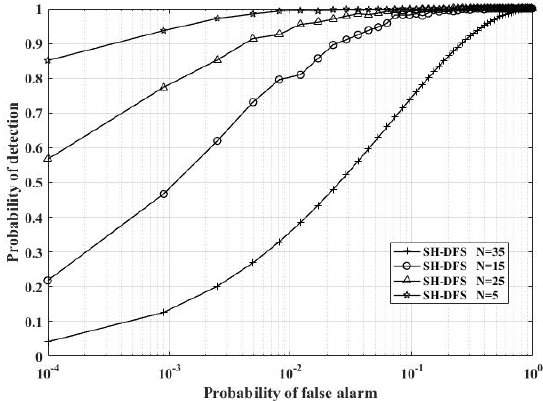
Figure 14. The probability of detection of the clustered distributed system with SH-DFS at a different number of local sensors versus the global desired probability of false alarm at the FC.